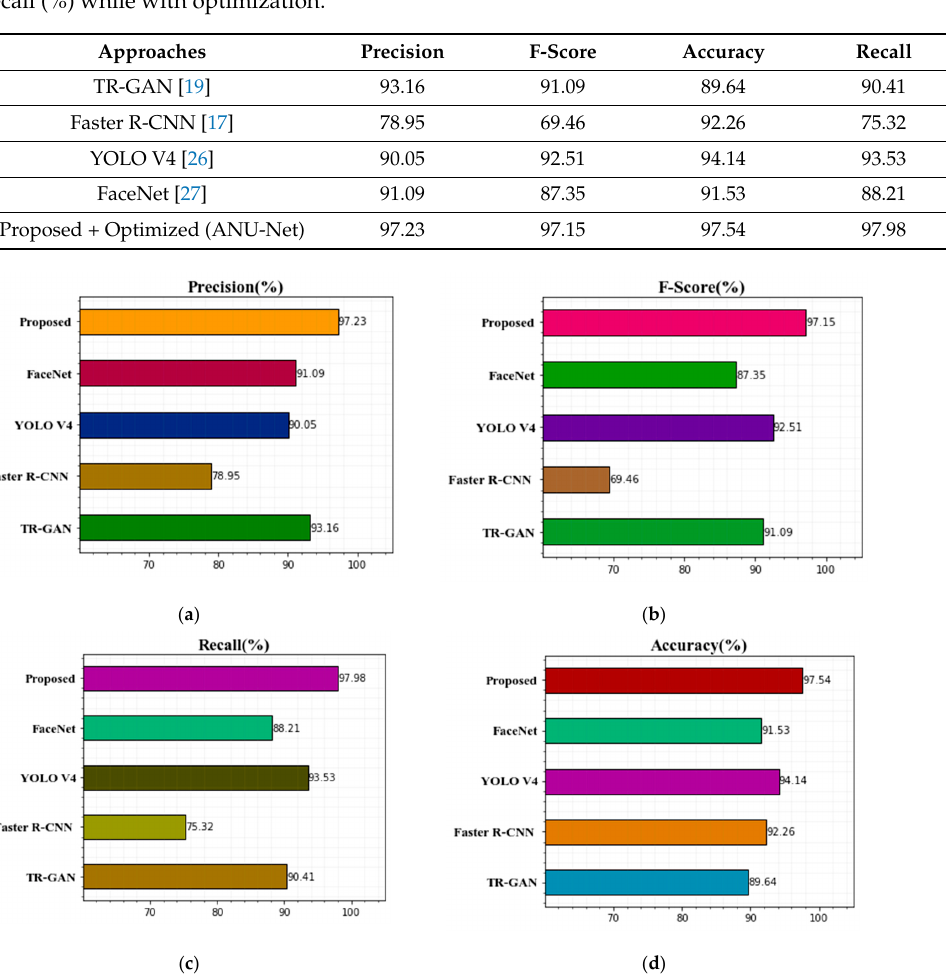
Figure 6. Comparison of the suggested technique’s classification results with previous methods with optimization algorithm ( a ) precision, ( b ) F-score, ( c ) recall, and ( d ) accuracy.